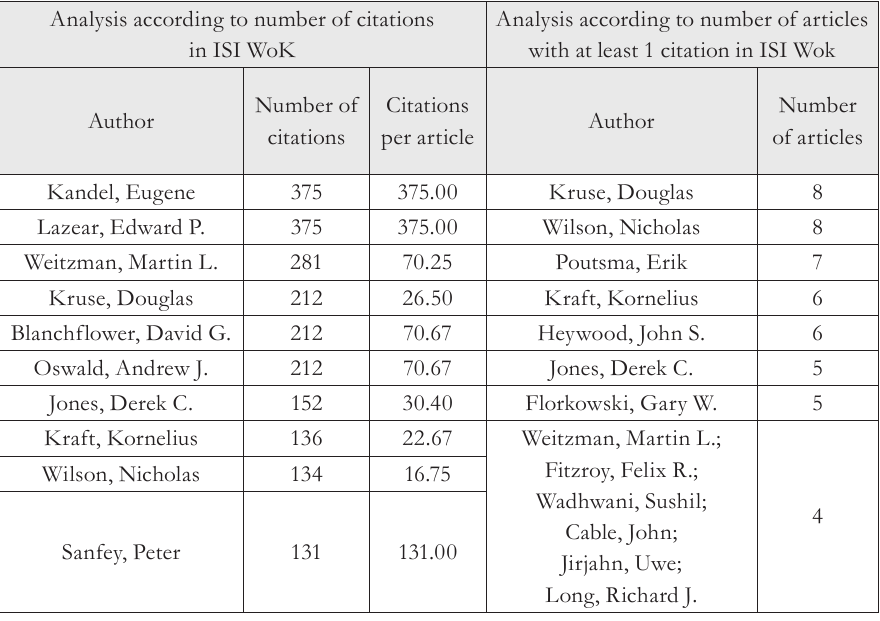
Tab. 1 – Analysis of authors according to the number of citation and according to the number of articles. Source: own analysis based on data from ISI Web of